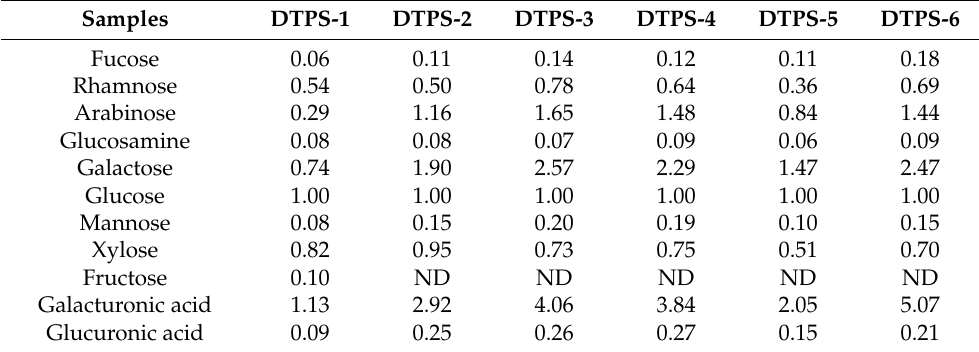
Table 2. Monosaccharide composition (molar %) of different